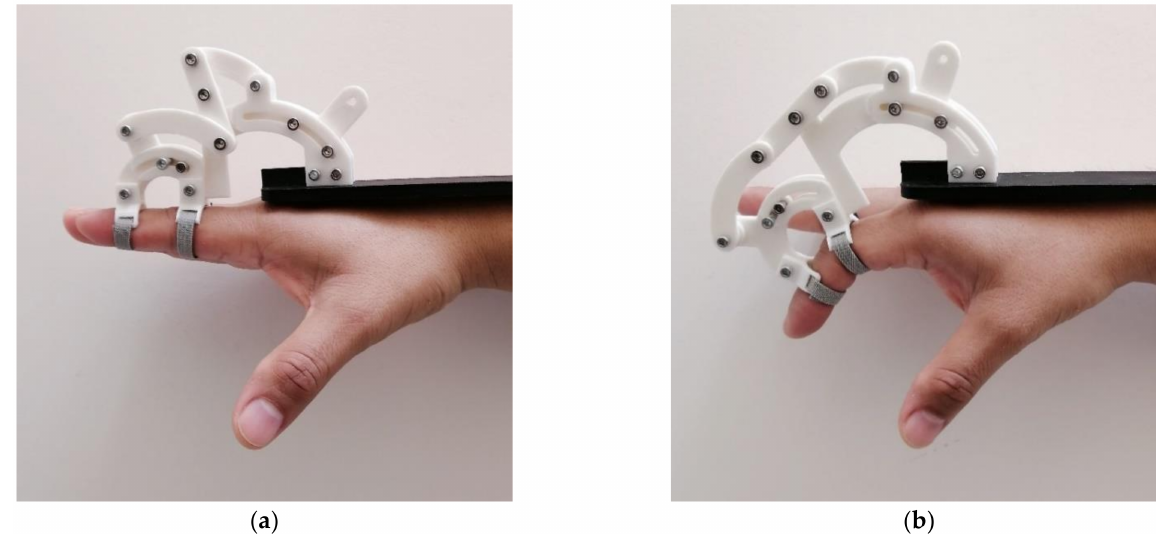
Figure 11. Physical prototype for the proposed design. ( a ) Initial position and ( b ) final